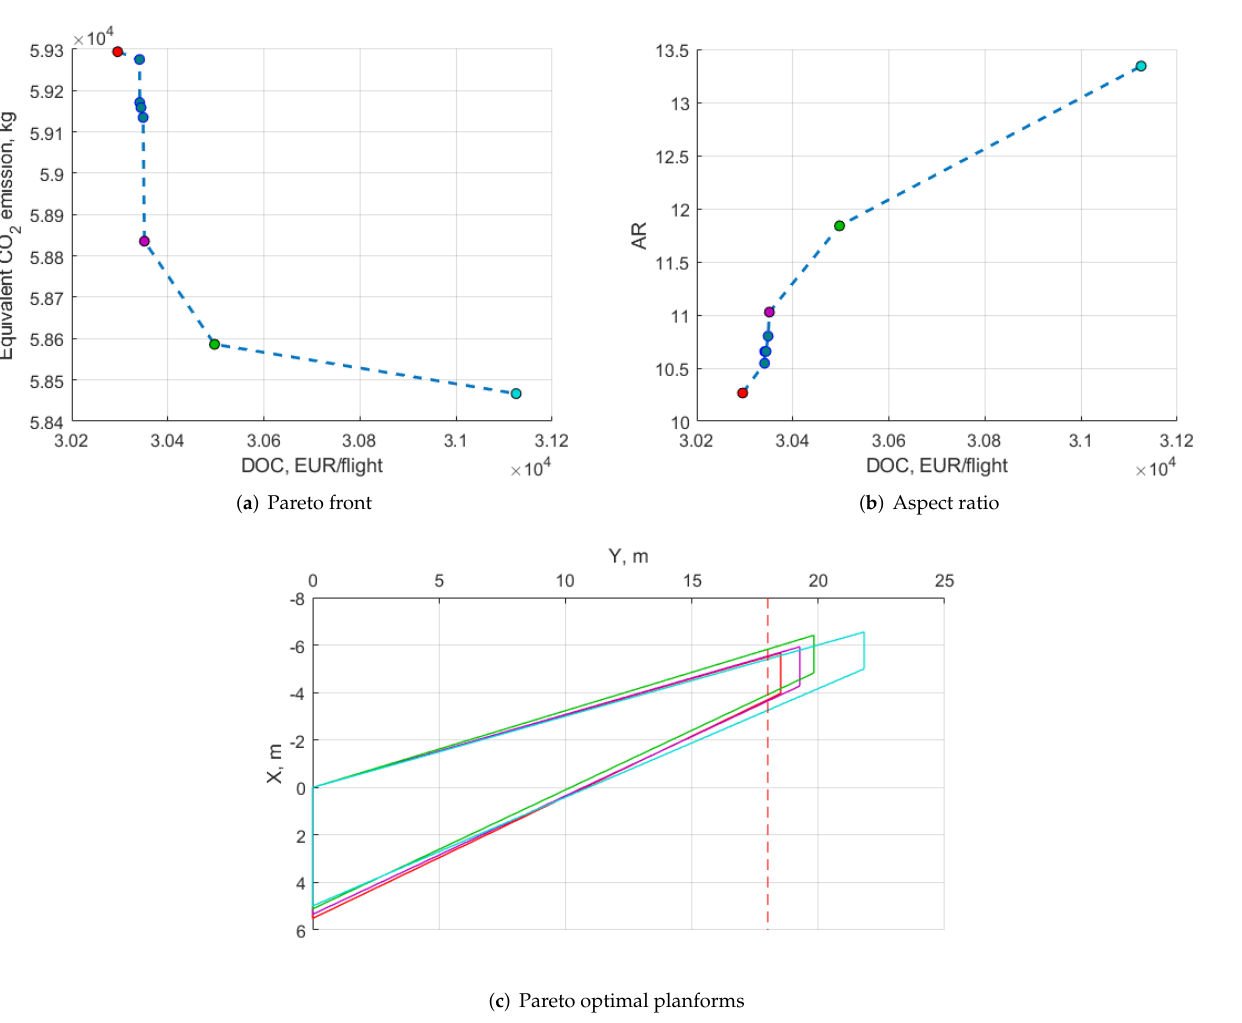
Figure A2. Optimization results for the forward-swept NLF aircraft with a folding